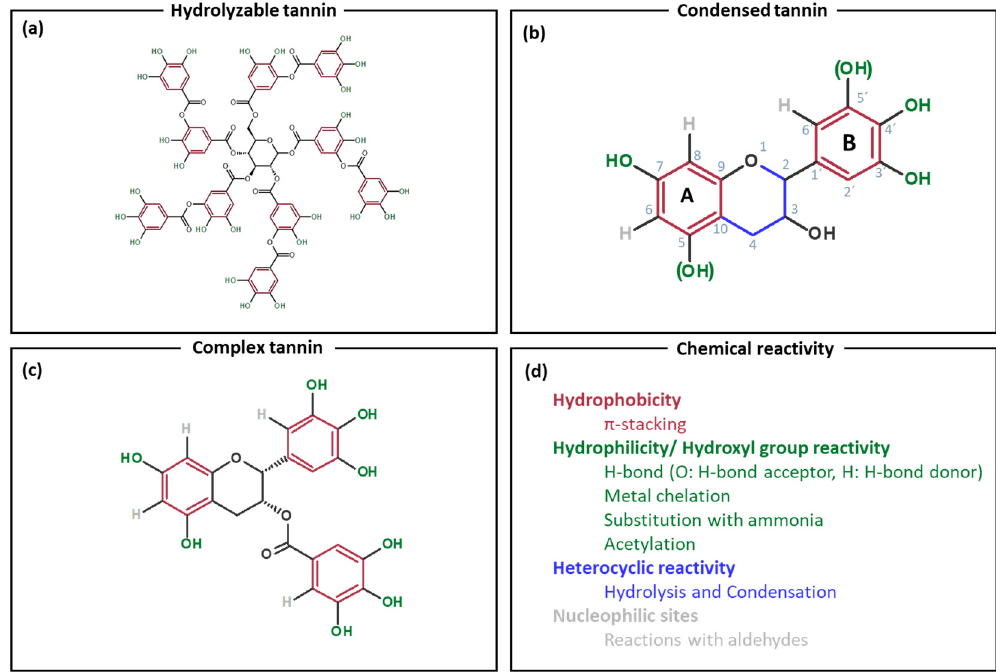
Figure 1. Example structures for different classes of tannins. ( a ) Structure of a tannic acid (TA) belonging to the hydrolysable tannins. ( b ) The monomeric flavonoid unit of condensed tannins which is usually connected to adjacent units at positions 4 and 6 or 8. ( c ) Epigallocatechin-gallate as an example for complex tannins. ( d ) Most important chemical reactivity properties of tannins color-coded in accordance with the respectively involved functional groups or moieties.